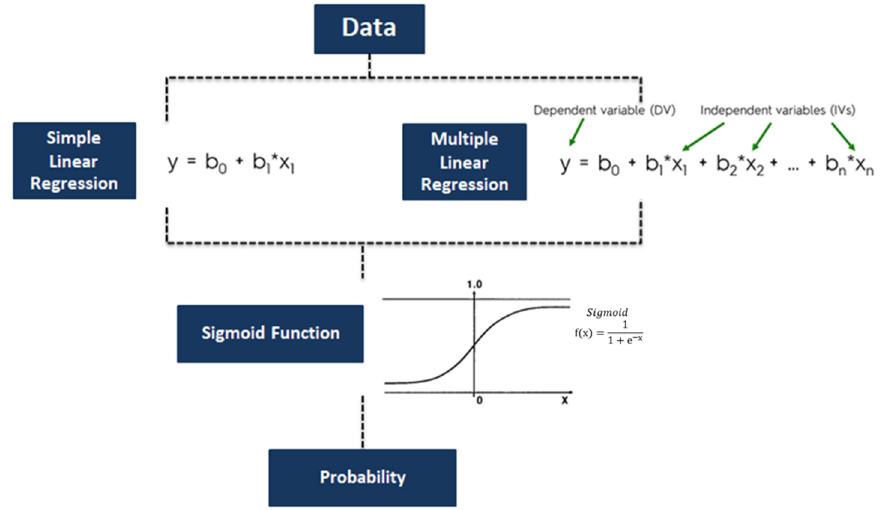
Figure 2. Logistic Regression modeling process diagram.